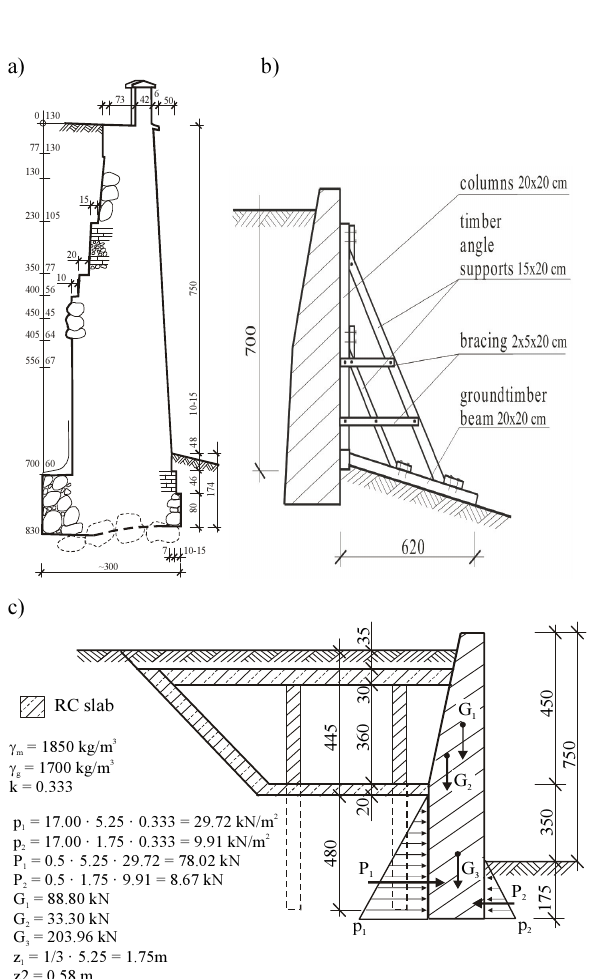
Fig. 12. Protection of the retaining walls: a) retaining wall diag- ram; b) timber bracings for temporary support; c) diagram of the unloading chamber behind the eastern retaining wall